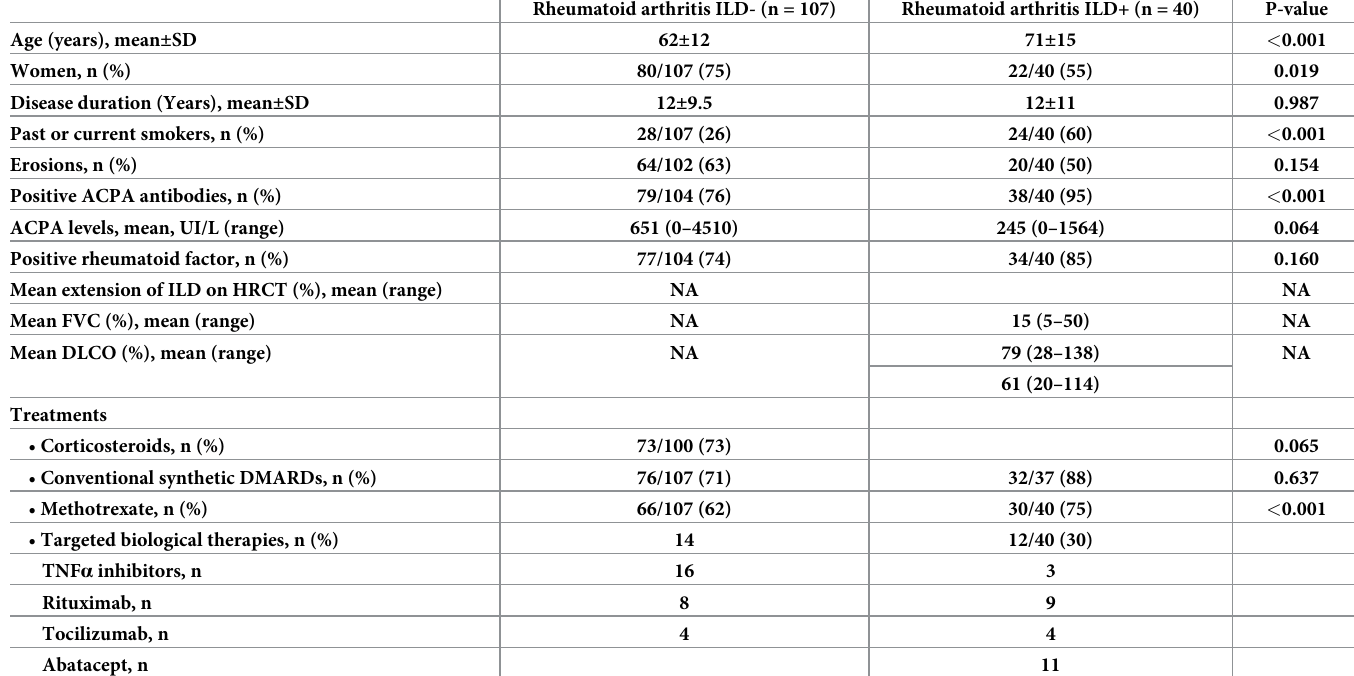
Table 1. Characteristics of included